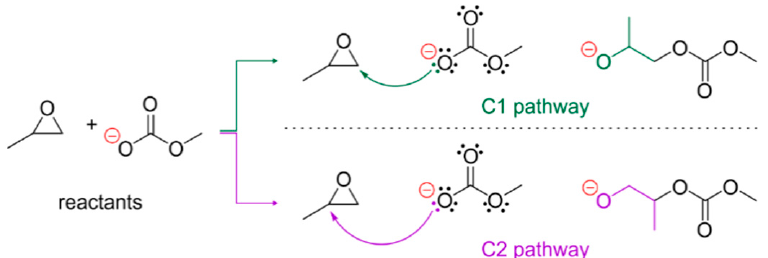
Figure 3. Possible pathways for coupling reaction of 1,2 ‐ epoxypropane and methylcarbonate. Two products can be potentially formed due to the attack of the nucleophile on either methylene or methine carbon atom (C1 and C2 pathway, respectively).